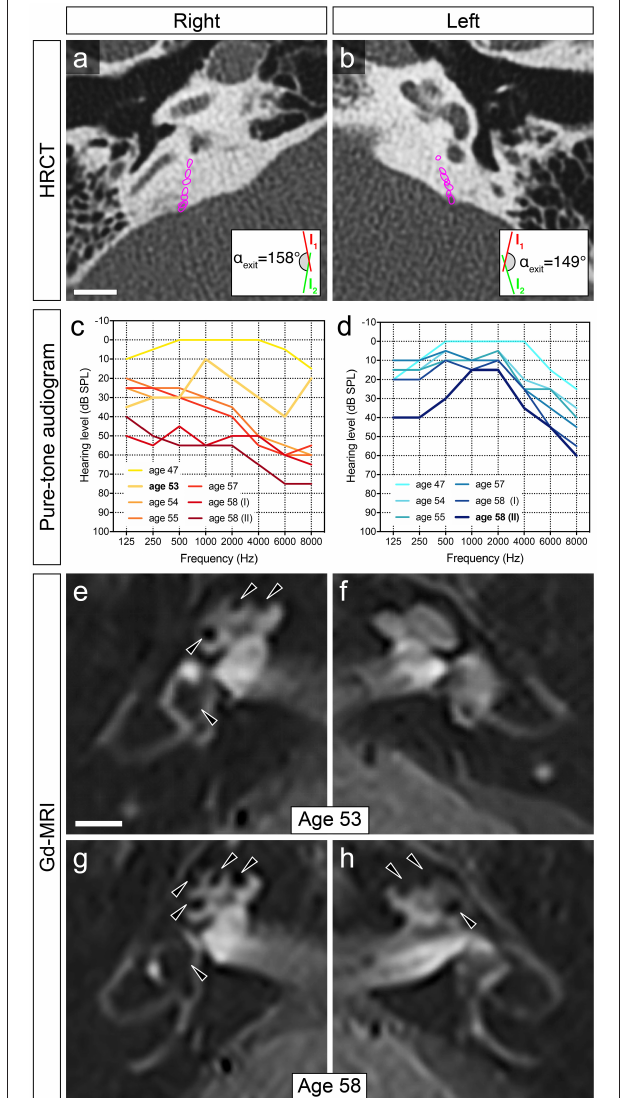
FIGURE 3 | Exemplary clinical case progressing to bilateral disease. (a,b) In this patient, ATVA measurements on temporal bone HRCT images performed at age 53 determined angles ( α exit ) consistent with bilateral ES hypoplasia (2D-reconstructed course of the vestibular aqueduct outlined in magenta). Scale bar: 5mm. (c,d) Audiogram data (air conduction thresholds) before MD first manifested (age 47), after onset of unilateral (right) MD [ages 53–58 (I)], and shortly after progression to bilateral disease [age 58 (II)]. (e,f) Gd-MRI at the time point of initial MD diagnosis (age 53) demonstrated grade 1 (18) cochleovestibular hydrops (black arrowheads) in the right inner ear. (g,h) Sequential Gd-MRI, after clinical and audiometric data indicated